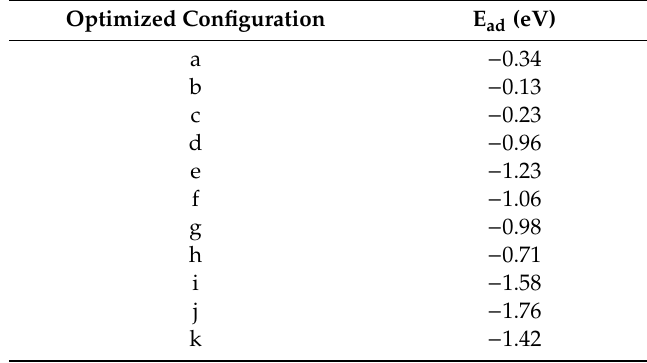
Table 5. Adsorption energies of glucose on the chalcopyrite (0 0 1)